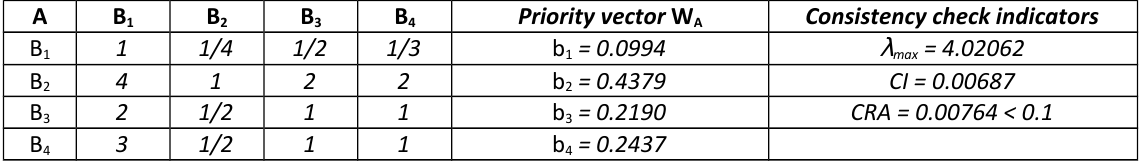
Table 3. Criteria matrix A and its consistency check